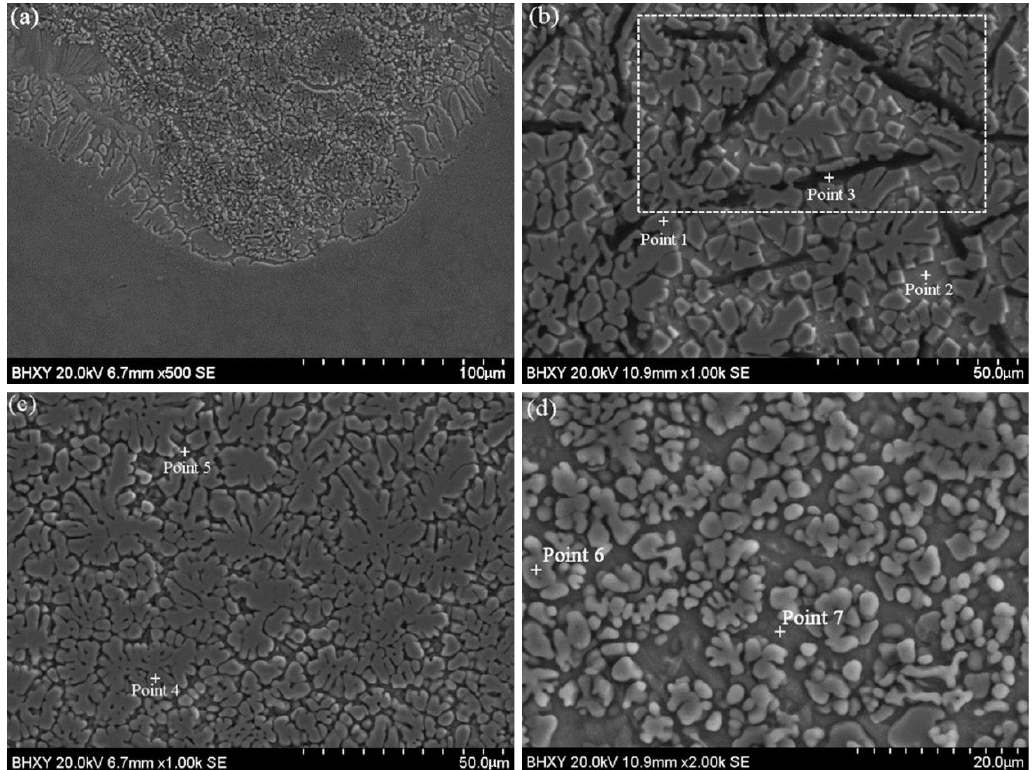
Figure 3. SEM morphologies of the coating: ( a ) the bonding layer; ( b ) the upper layer; ( c ) the middle layer; ( d ) the bottom layer.